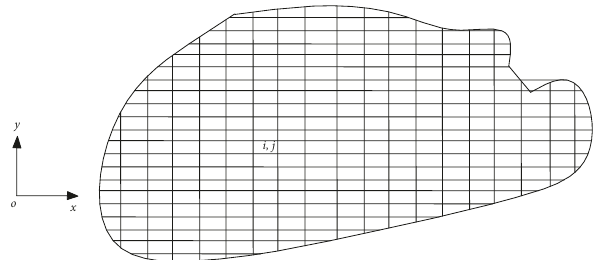
Figure 3: The projection of 3D failure mass in the xoy